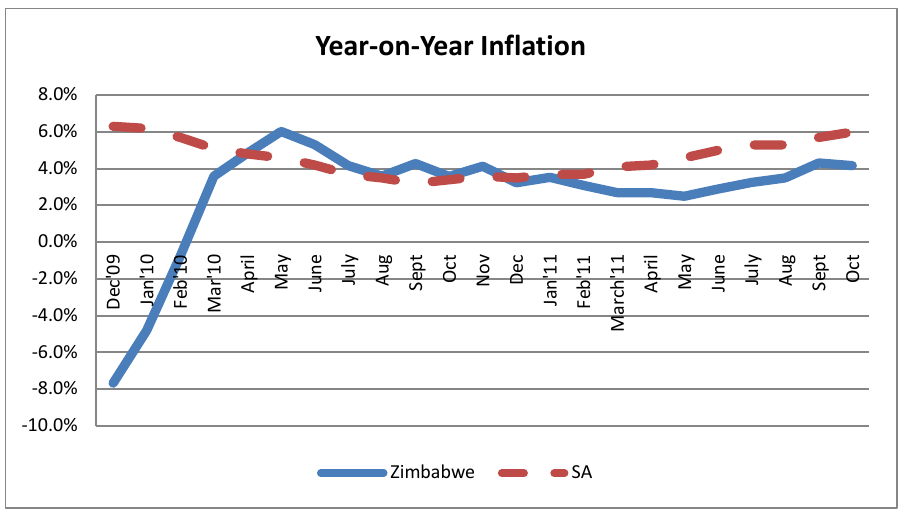
Figure 3: Year-on-Year Inflation in Zimbabwe and South Africa (%) Source: Zimstats (2011 and 2012); Statistics South Africa